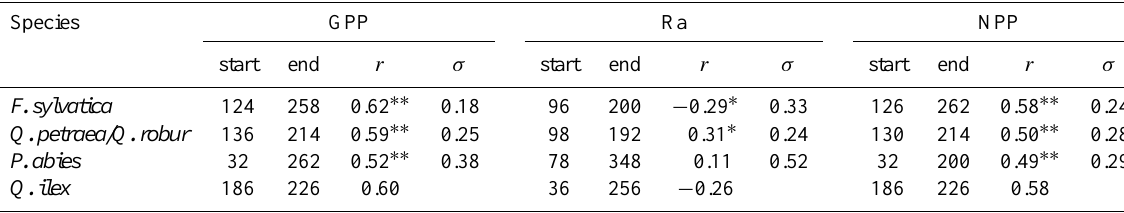
Table 3. Relationships of annual wood growth and the components of the seasonal forest carbon balance: NPP, GPP and Ra. The start and end terms (day of the year) indicate the carbon flux period that yielded the maximum value for the median of the growth-flux correlations among sites. The r term is the maximum obtained for the median of the site-specific Pearson correlation coefficients; values that are significantly different from 0 are indicated ( ∗ indicates P < 0 . 05 and ∗∗ indicates P < 0 . 001). The σ term is the standard deviation of the Pearson correlation values among